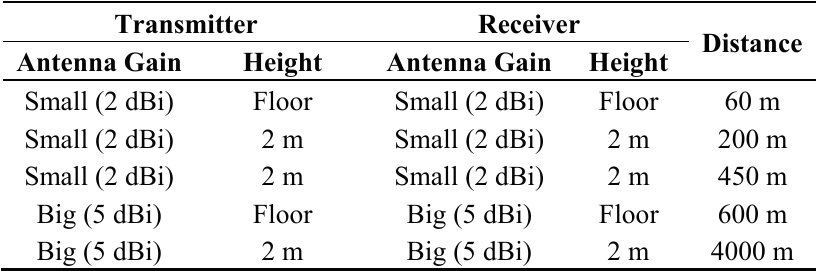
Table 3. Maximum communication range of Xbee PRO S2.